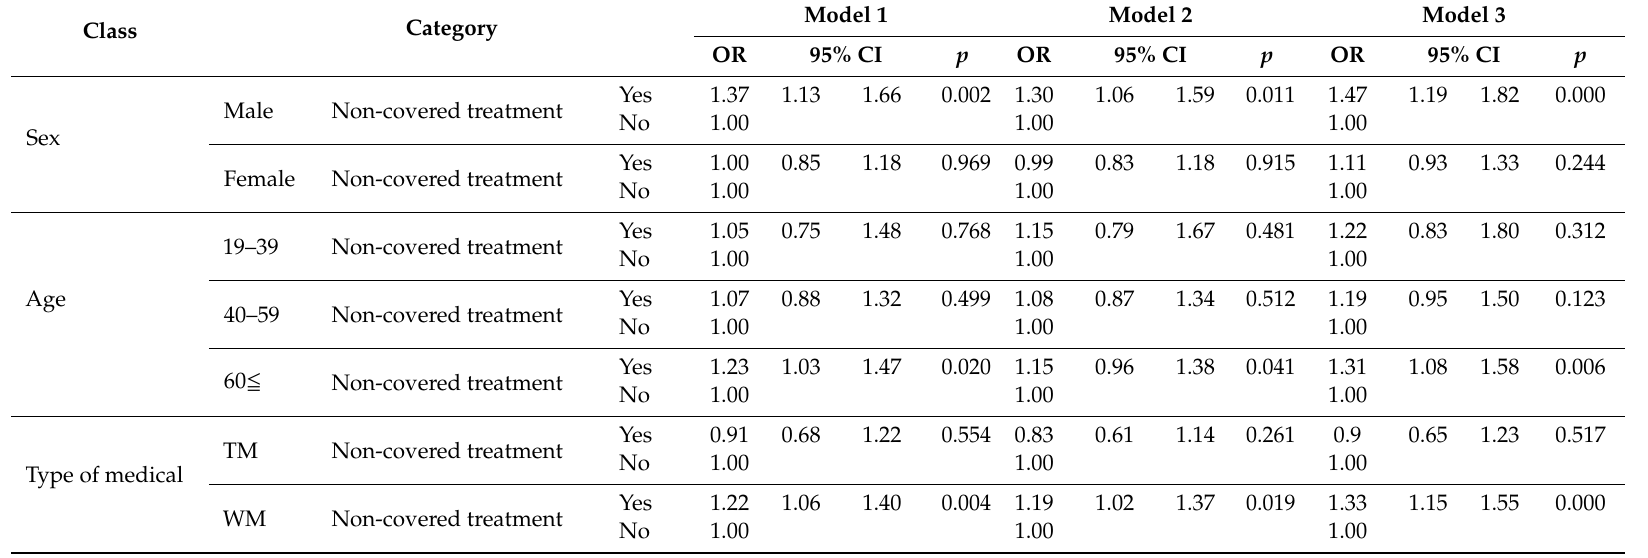
Model 1 Model 2 Model 3 OR